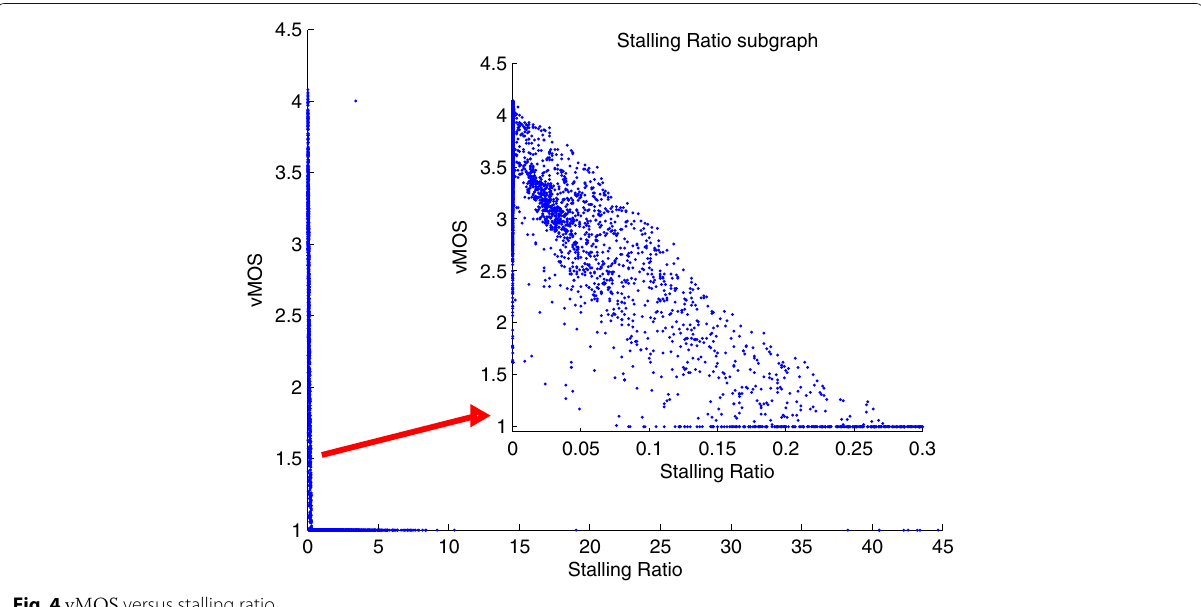
Fig. 4 vMOS versus stalling ratio